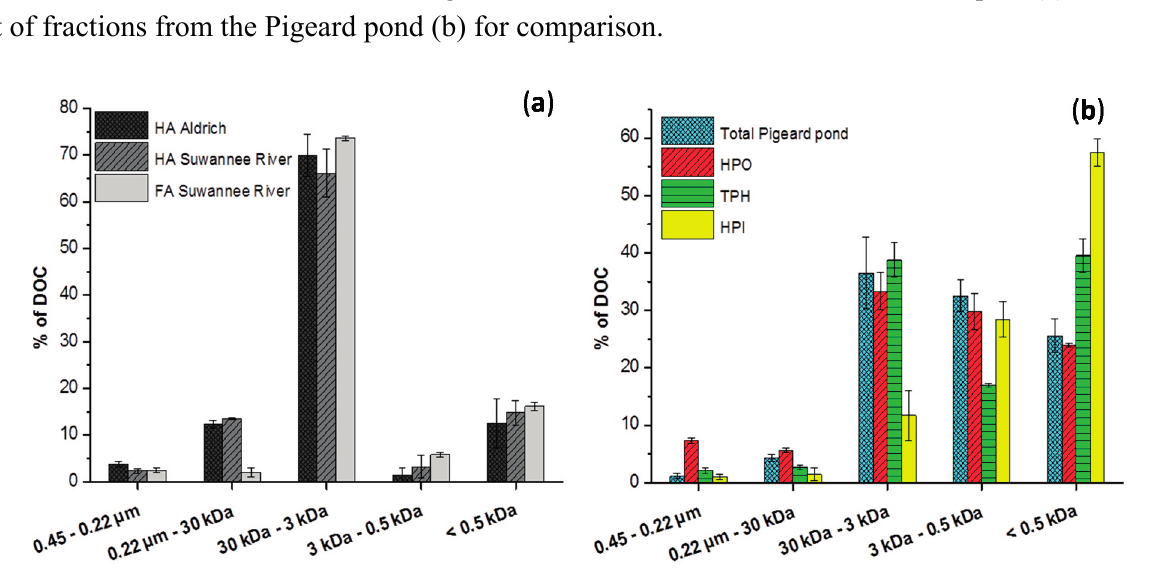
Figure 3. Size fractionation of HA and FA from peat and the Suwannee river are given in ( a ) and that from Pigeard pond in ( b